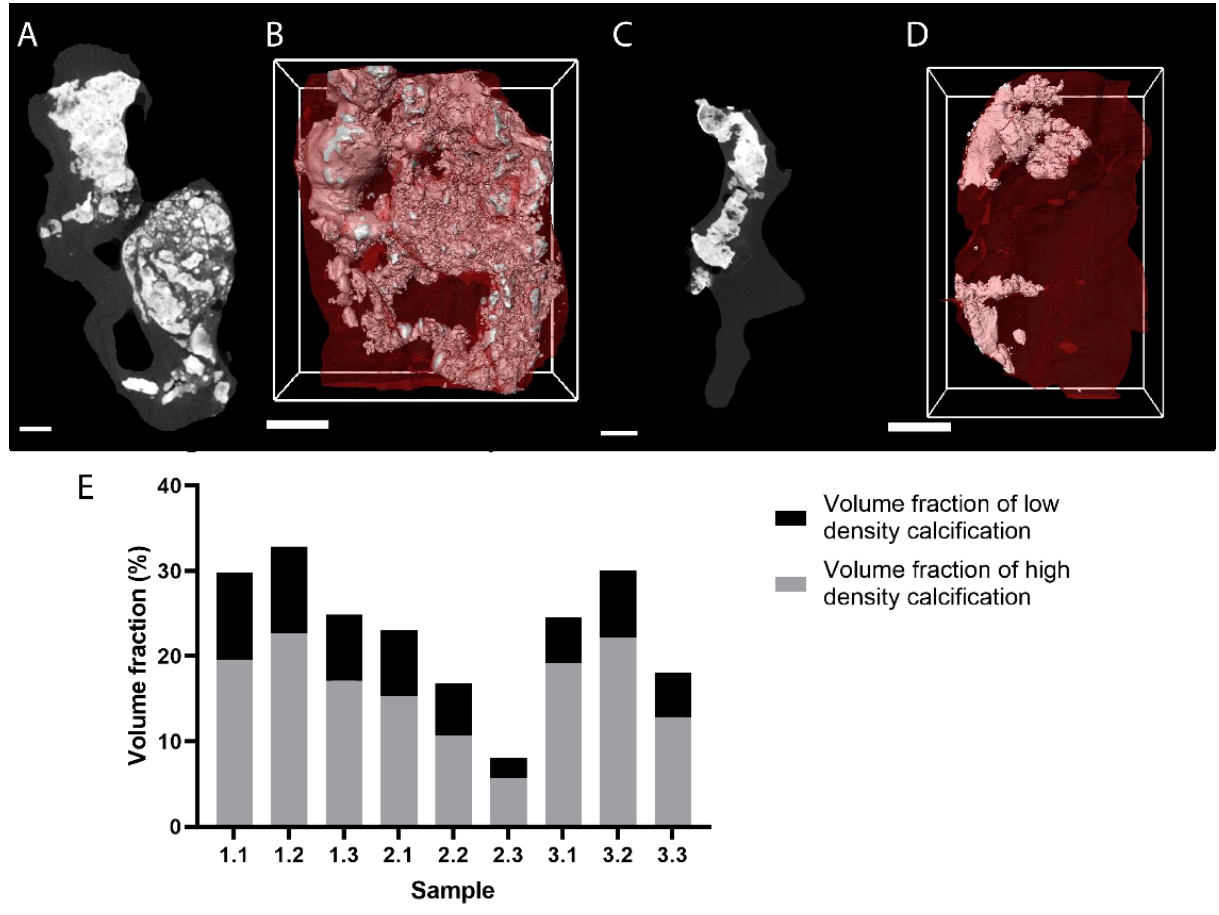
Figure 4. MicroCT imaging of fresh calcified aortic valves ( n = 3) from human patients that were explanted during aortic valve replacement (Appendix A). ( A , C ) Cross-sectional 2D microCT image (no contrast enhancement) of samples 1.2 and 2.3, respectively, after the region of interest (ROI) selection. ( B , D ) 3D rendering of samples 1.2 and 2.3, respectively; calcifications are white and soft tissue red. ( E ) Volume fraction of the calcifications in the entire valve. Semiautomatic segmentation of the soft tissue and the different densities of calcification were done based on greyscale differences. Scale bars represent 1